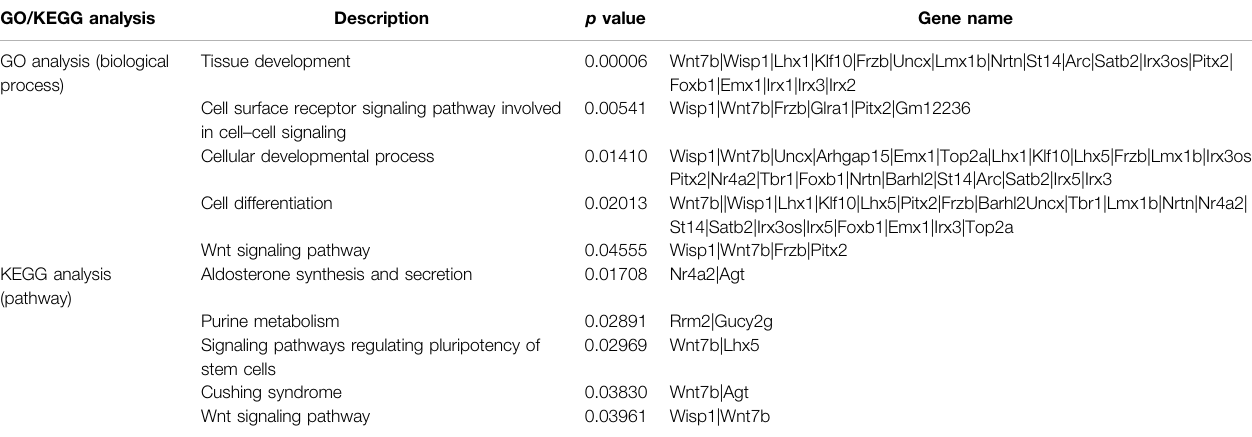
TABLE 3 | GO and KEGG analyses of differentially expressed genes among the sham treatment group, intracerebral hemorrhage model group, and febuxostat group. GO/KEGG